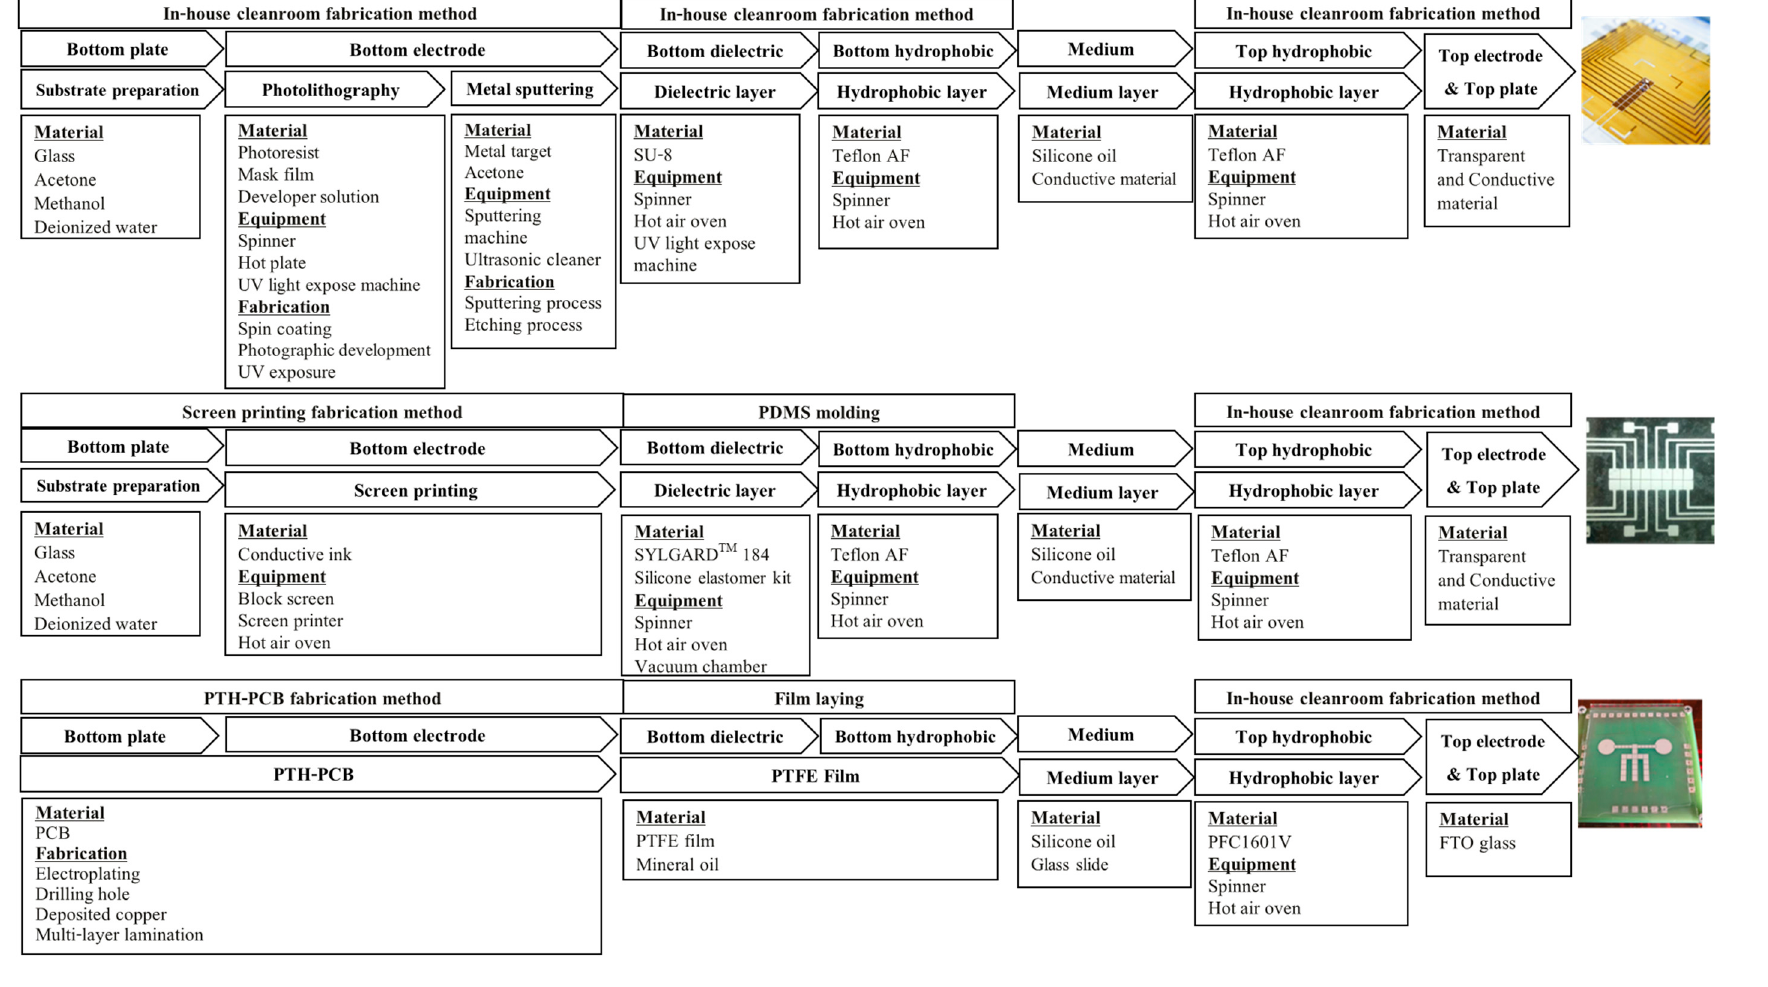
Figure 4. Comparison between the proposed bottom procedure and another conventional EWOD fabrication procedure.